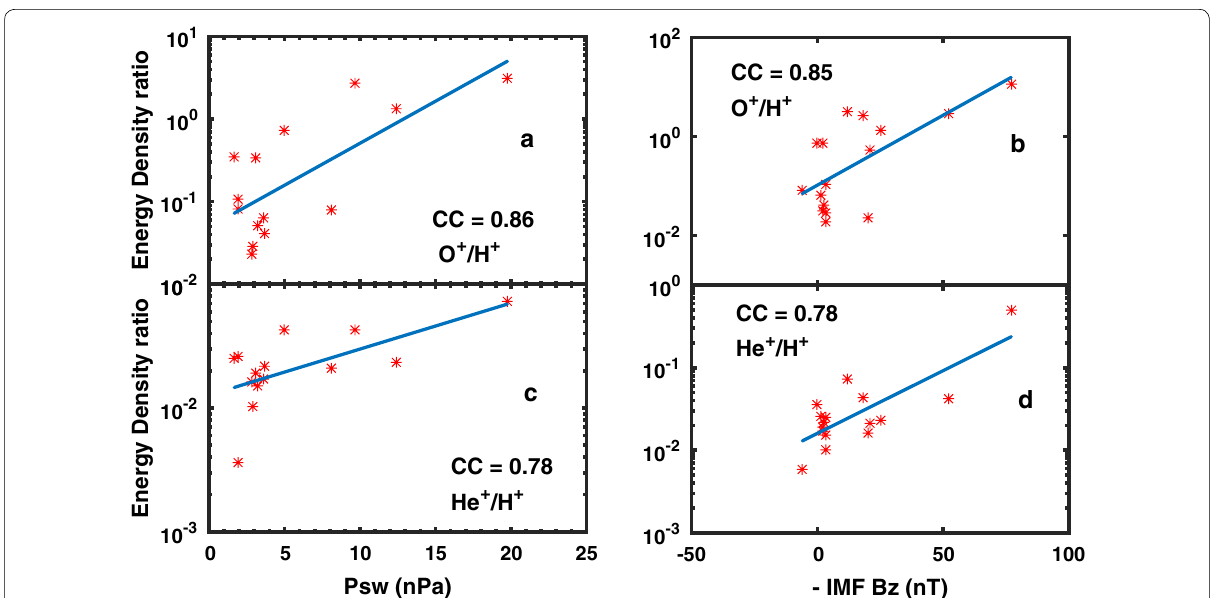
Fig. 7 The correlation analysis of IMF Bz and Psw with the energy density ratio O + /H + and He + /H